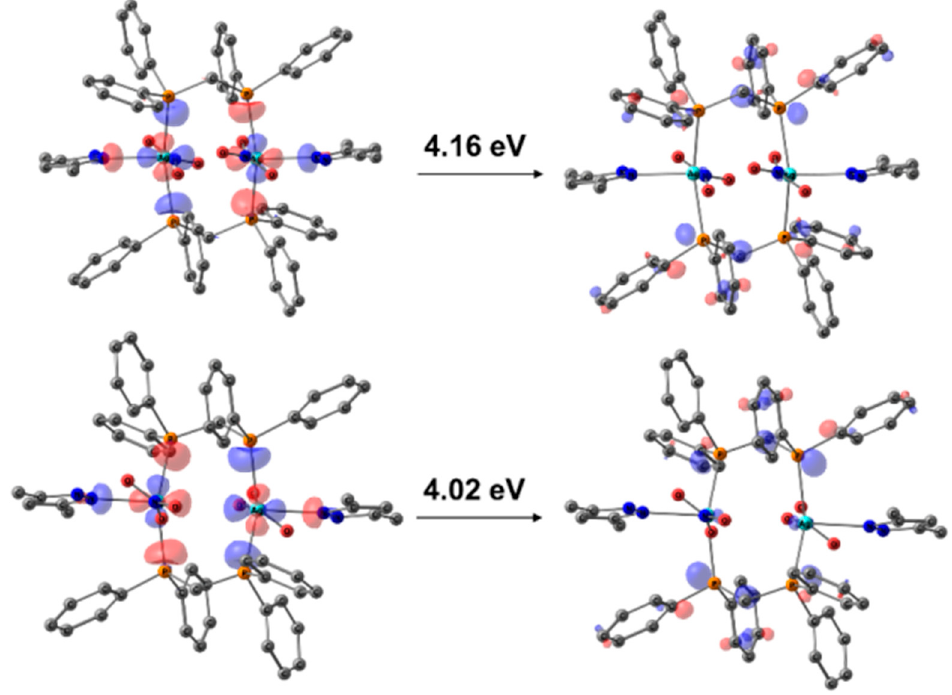
Figure 6. HONTO and LUNTO for the S 0 → S 1 and S 0 → T 6 in complex 2b as the isosurface at 0.05 au.